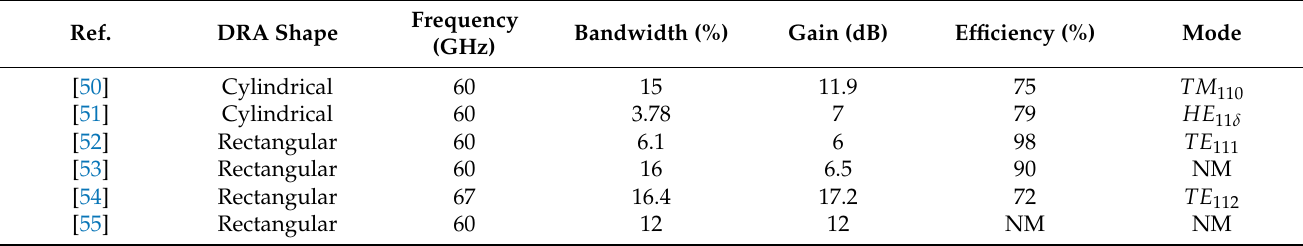
Table 3. Comparison between the performance of linear polarized DRAs at V band. Ref.